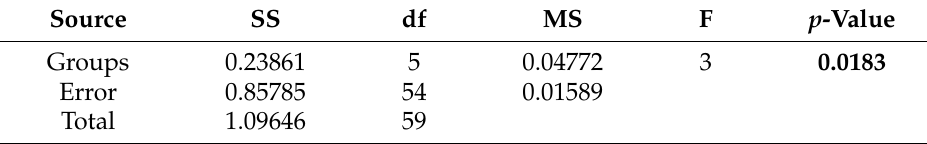
Table 16. ANOVA table results on dataset